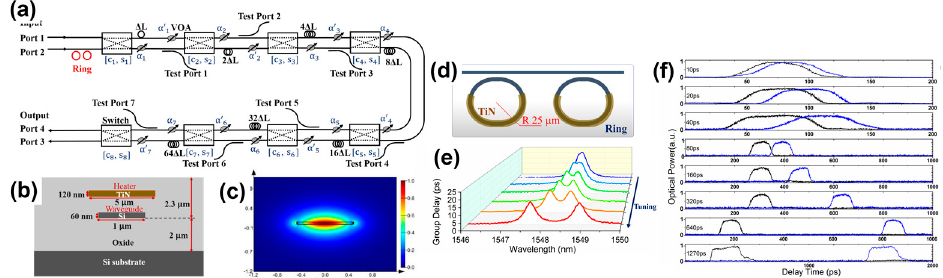
Figure 10. ( a ) Architecture of the continuously tunable optical delay line structure reported in [95]. ( b ) Cross-sectional structure of the ultra-thin waveguide with a titanium nitride (TiN) heater on top. ( c ) Simulated x-component of the electronic field distribution for the fundamental transverse electric (TE) mode. ( d ) Dual-ring slow-light delay line structure. ( e ) Evolution of the ring delay spectrum upon thermal tuning. ( f ) Optical pulse waveforms after passing through the switchable delay line. Black curves: reference pulses; blue curves: delayed pulses. ( g ) Optical pulse waveforms after passing through the longest optical path with delay fine tuning by the ring resonators. ( h ) Eye diagrams of a 30 Gb/s pseudo-random binary sequences (PRBS) signal after various delays; Gb/s: gigabits per second. Courtesy of Linjie Zhou [95].